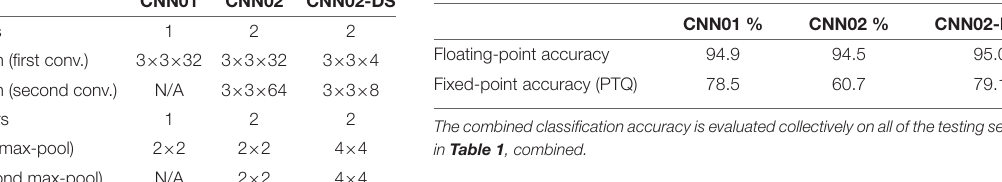
TABLE 5 | Combined classification accuracy for true NB, LE, and HE ROIs for floating-point vs. PTQ fixed-point implementations of the trained networks.